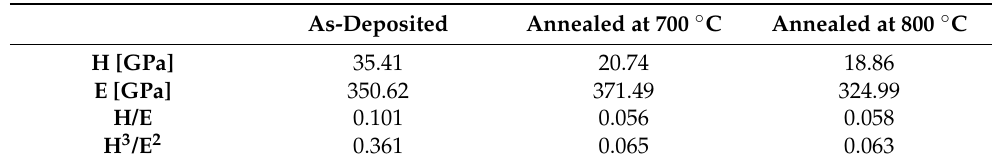
Table 4. Nanohardness (H), elastic modulus (E) and the calculated H/E and H 3 /E 2 ratios of the studied